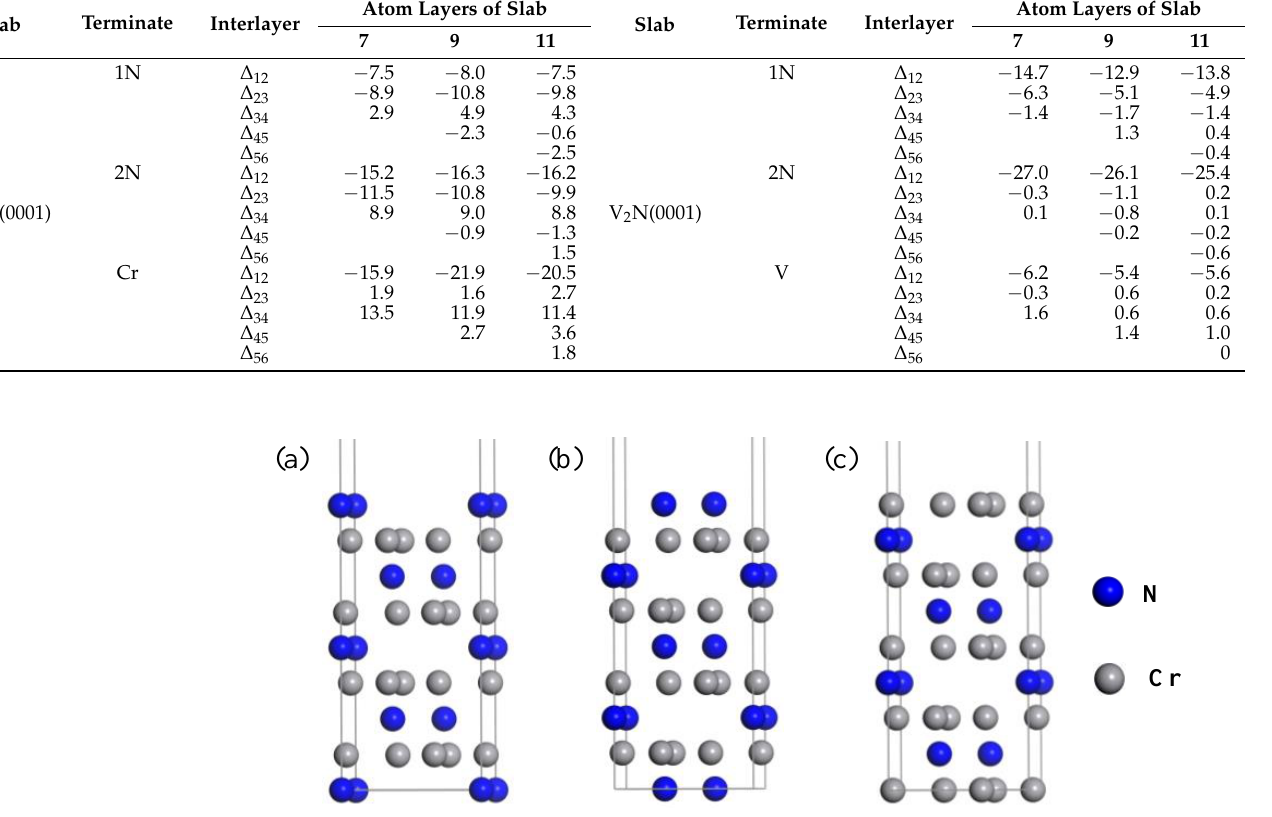
Figure 1. Three different terminations of Cr 2 N(0001): ( a ) 1N-T, ( b ) 2N-T, and ( c ) Cr-T terminations. The V 2 N(0001) surface has similar configurations.